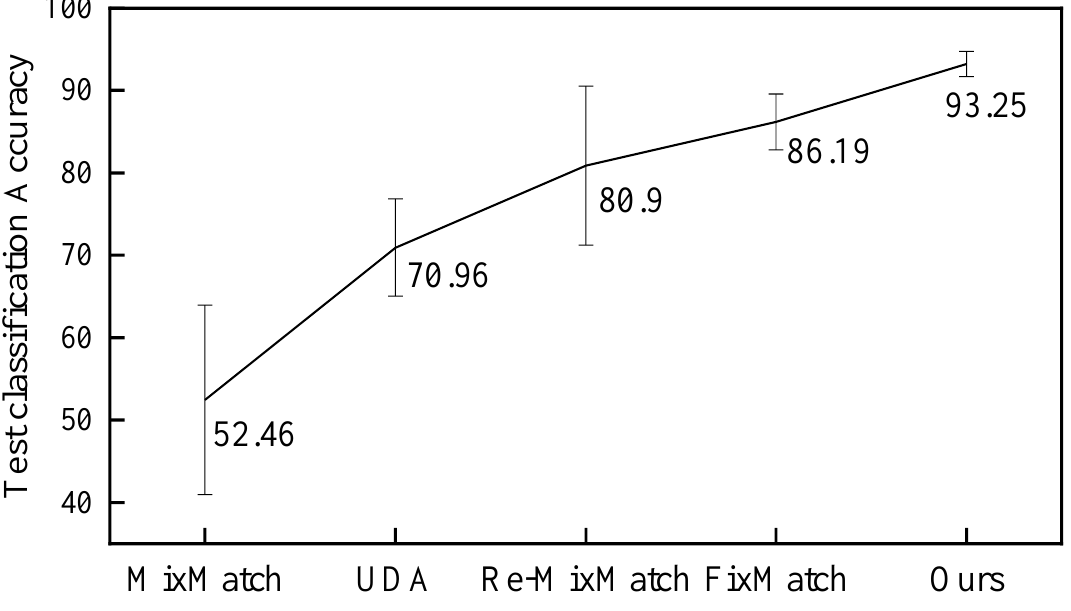
Figure 9 Accuracy of different models trained on the CIFAR-10 dataset with 40 labeled samples on the test